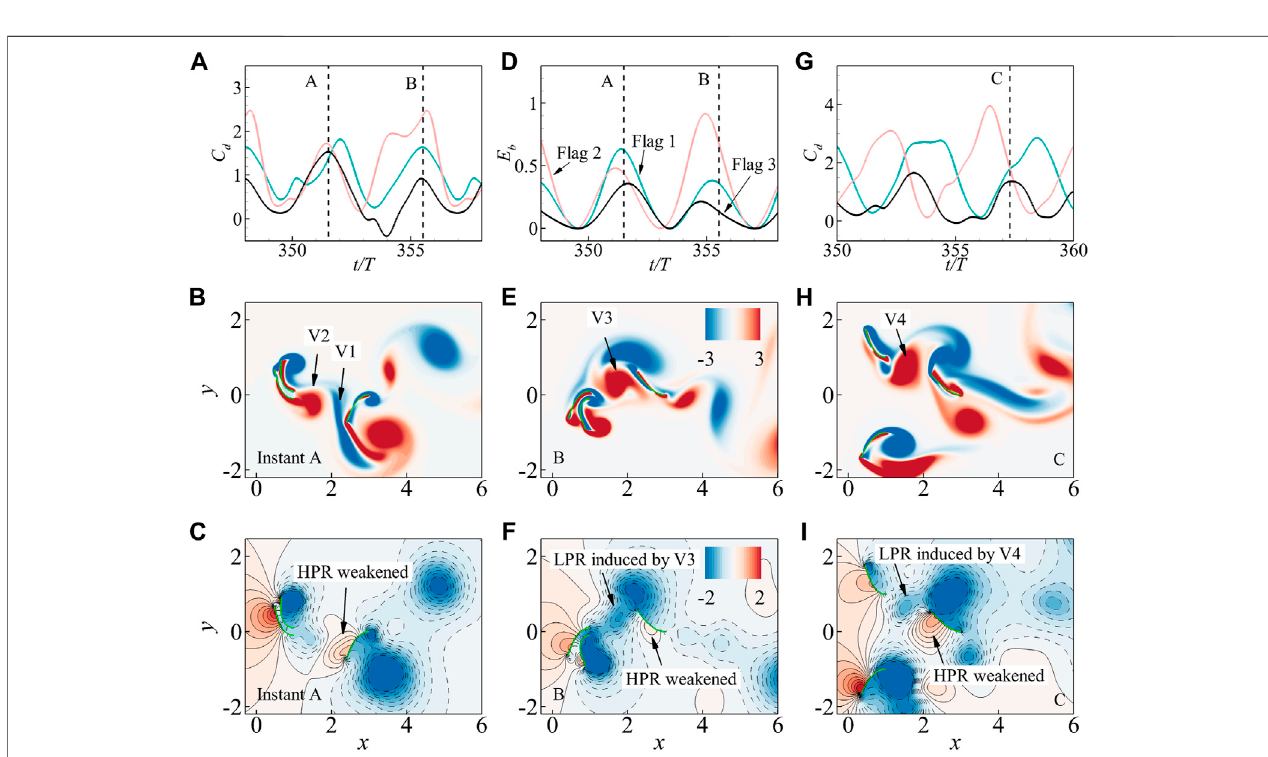
FIGURE 13 | The unsteady dynamics of the system for the typical cases with G =1, H =0.2 (A – F) and 2 (G – I) . For case with G =1 and H =0.2, the instantaneous dragcoef fi cient C d (A) and thebendingenergy E b (D) asafunction oftime foreach fl agareprovided;Also, theinstantaneousvorticity (B,E) and pressure (C,F) contours at the typical instant A (B,C) and B (E,F) are plotted. For case with G =1 and G =2, the time-variation of C d for each fl ag (G) , and the instantaneous vorticity (H) and pressure (I) contours at the typical instant C are